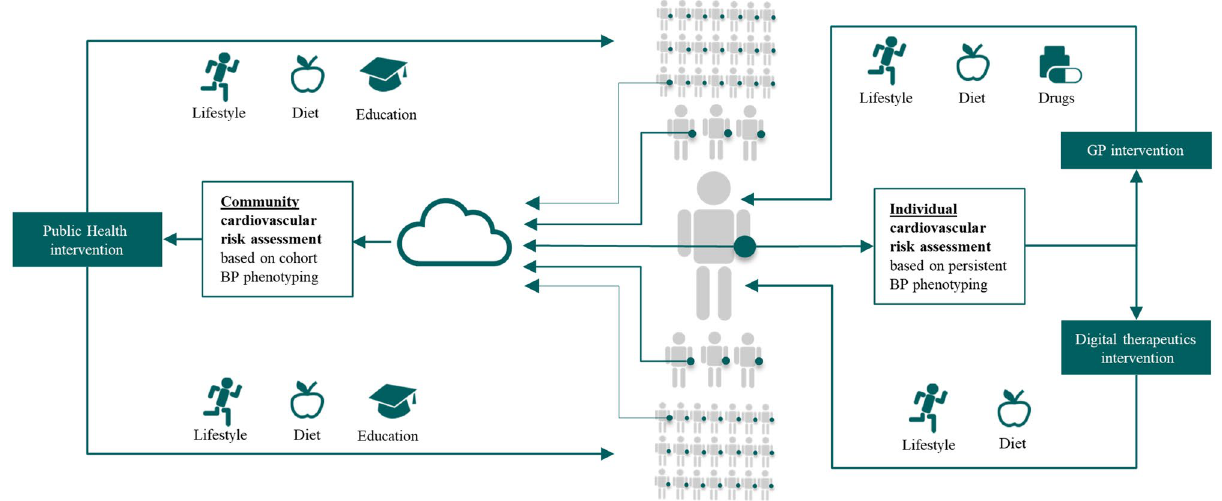
Figure 8. Introduction to the concept of BP phenotyping using persistent BP monitoring at the wrist, enabling a new category of studies and programs to investigate how longitudinal 24/7 measurements can improve cardiovascular outcomes at both individual and community